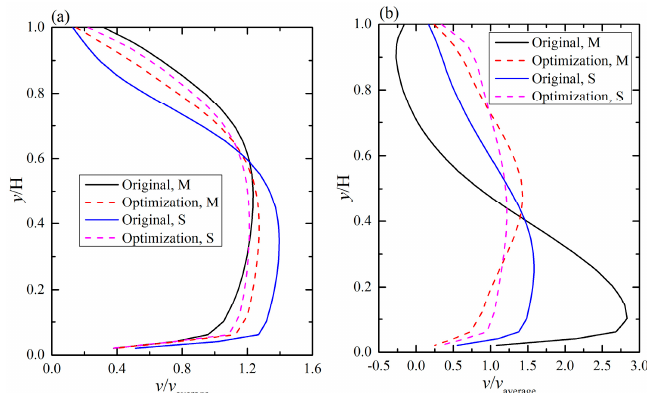
Figure 15. Velocity profiles at the orifice cross-section: ( a ) inflow; ( b ) outflow.